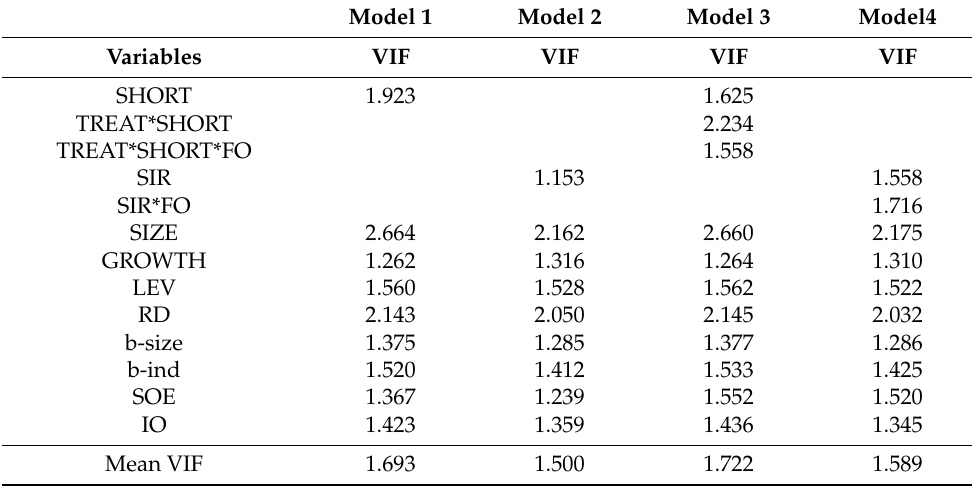
Table 11. VIF scores of independent variables in four